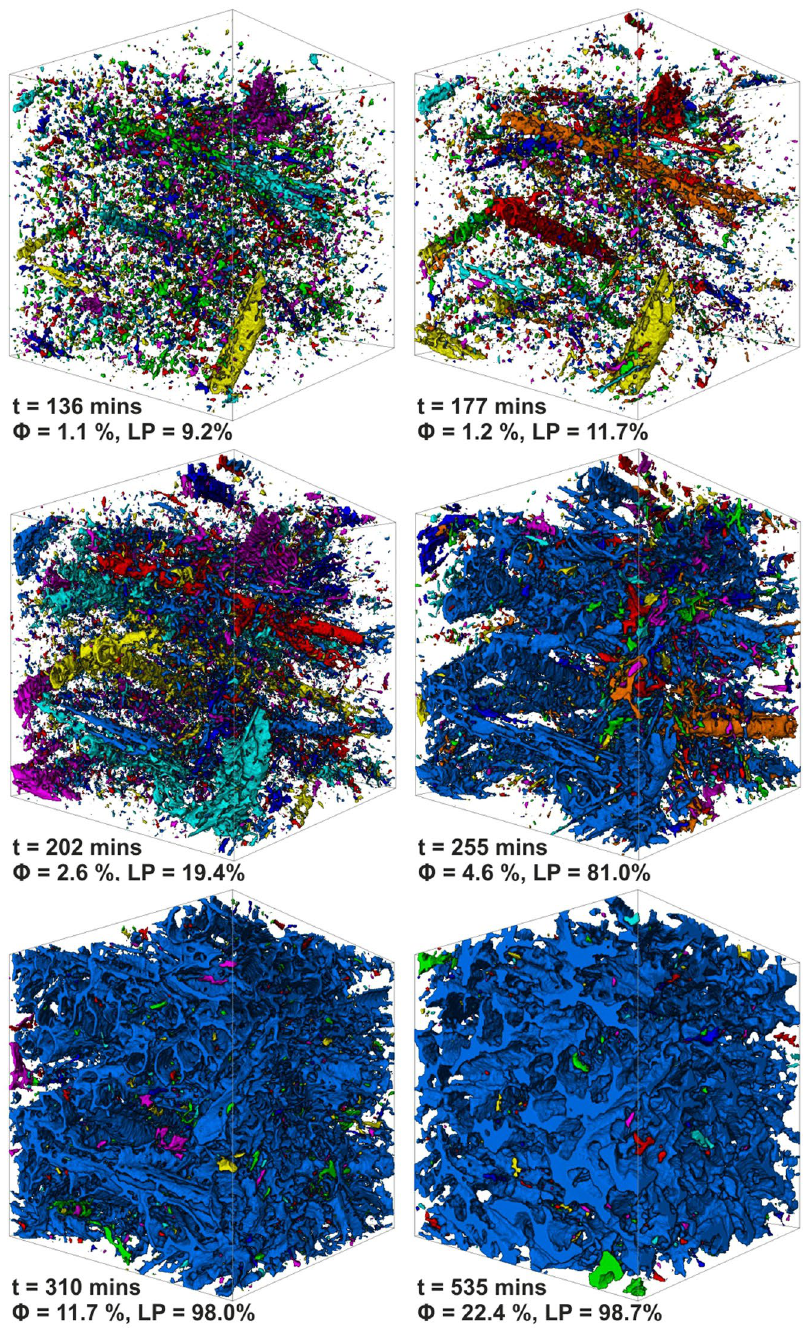
Figure 2. 3-dimensional reconstructions of the pore network with time. Different pore clusters appear in different colours in the reconstructions. The analysed subvolume is a cube with a side length of 975 μ m. Until 177 minutes there are thousands of isolated pores, with the largest pore cluster (LP) only comprising 11.7% of the pore network at this time. By 202 minutes the largest pores are beginning to expand and by 255 minutes most of them are interconnected with the largest pore cluster (which appears blue) comprising 81% of the total pore network. After 310 minutes this pore cluster dominates the drainage architecture (98%) with only a few isolated small pores